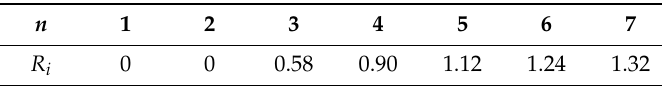
Table 3. Average random consistency